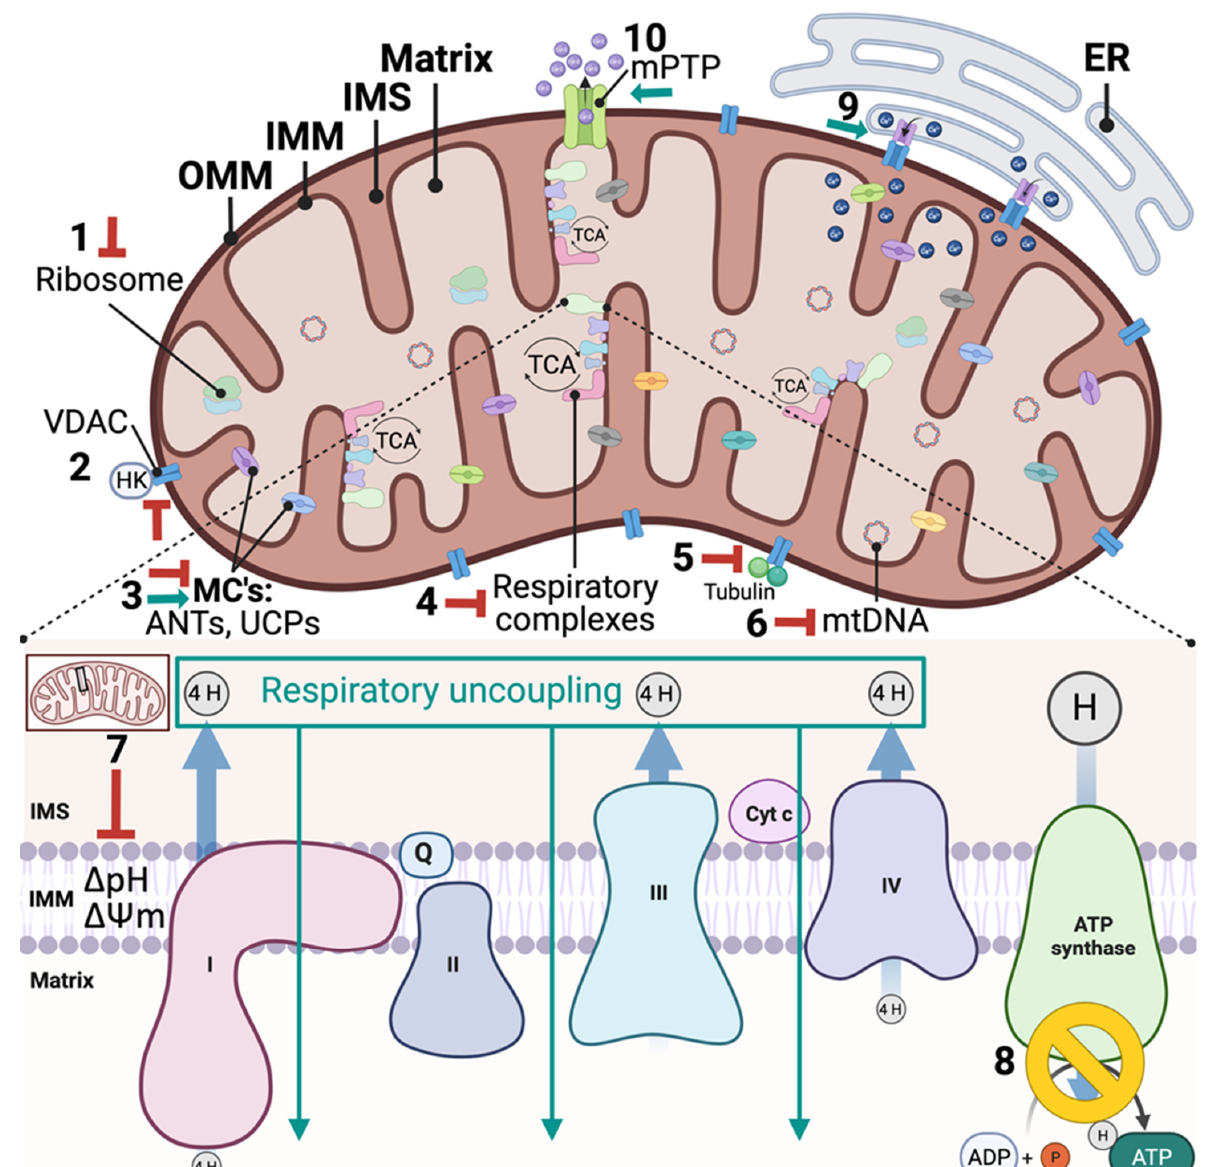
Figure 1. Mitochondrial targets in the anti-cancer effects of phytochemicals. Phytochemicals exert anti-breast cancer effects by targeting various mitochondrial functions, such as: (1) mitochondrial ribosome protein translation, (2) hexokinase-VDAC interaction, (3) metabolite transport (such as inhibition of ANT or upregulation of UCPs), (4) respiratory complex activity, (5) tubulin-VDAC interactions, (6) mtDNA integrity, (7) maintenance of bioenergetic efficiency ( Δ pH and ΔΨ m) (8) ATP production, (9) ER-calcium influx into the mitochondrial matrix, and (10) intrinsic apoptosis signaling via mPTP-gated cytochrome c release. Abbreviations: OMM, outer mitochondrial mem- brane; IMM, inner mitochondrial membrane; IMS, inner mitochondrial membrane space; VDAC, voltage-dependent anionic channel; HK, hexokinase; MC’s, metabolite carriers; ANT, Adenine nucleotide translocase; UCP, uncoupling proteins; mtDNA, mitochondrial DNA; ER, endoplasmic reticulum; mPTP, mitochondrial permeability transition pore; ∆ pH, pH gradient; ∆Ψ m, mitochondrial mem- brane potential